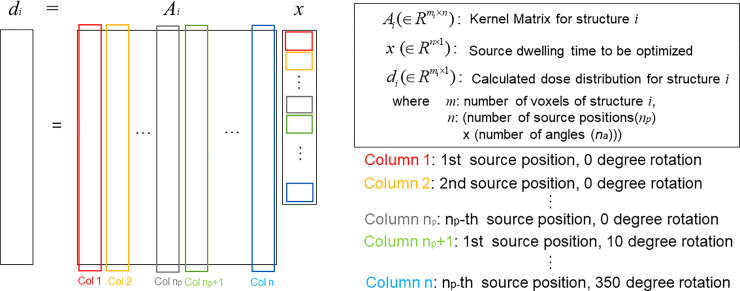
Formation of dose kernel matrix for each structure.Dose kernel matrix for each structure, where the dose distribution for each structure fills column of the matrix in a 1D-array.